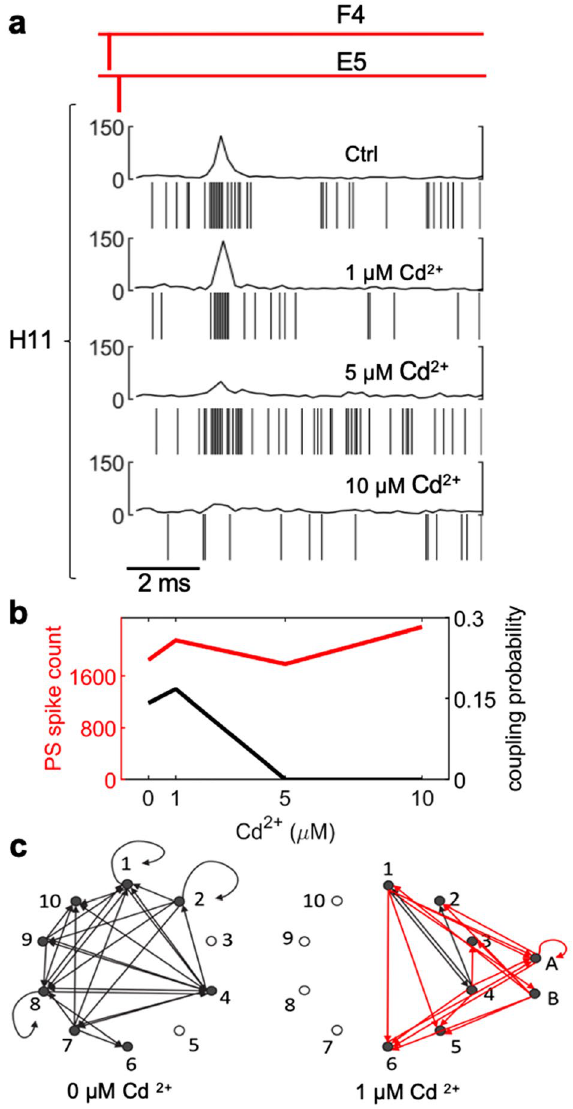
Figure 4. Cadmium alters coupling probabilities. ( a ) Propagation signal eAP’s detected at F4 and E5 with coupled spikes in H11 in the absence of cadmium and after addition of 1 µM, 5 µM, and 10 µM cadmium. Coordinated spiking activity in H11 after propagation signal spikes in F4 and E5 decreased dramatically and resulted in the absence of coordinated activity at 10 µM. ( b ) In this example, the total number of spikes from the propagating neuron detected in electrode F4 to E5 under control conditions was 1848 spikes and the coupling probability of the postsynaptic unit at H11 was 0.14. Addition of 1 µM Cd 2+ resulted in 2154 spikes in the propagating neuron and a coupling probability of 0.16 with H11. At 5 µM and 10 µM Cd 2+ , the spikes CCG at electrode H11 did not meet our criteria for coupling and were considered fully de-coupled; with 1784 and 2357 spikes in the propagating neuron, respectively. ( c ) Network graphs were constructed to visualize the couplings between only propagation signal spiking activity. 8 of 10 propagation signals (nodes) formed a total of 29 couplings (black edges) in control conditions. Addition of 1 µM Cd 2+ resulted in loss of 26 edges present in control and the appearance of 17 couplings (red edges). No couplings were detected at 5 µM or 10 µM Cd 2+ (1 MEA was used for 4 recording sessions for a – c